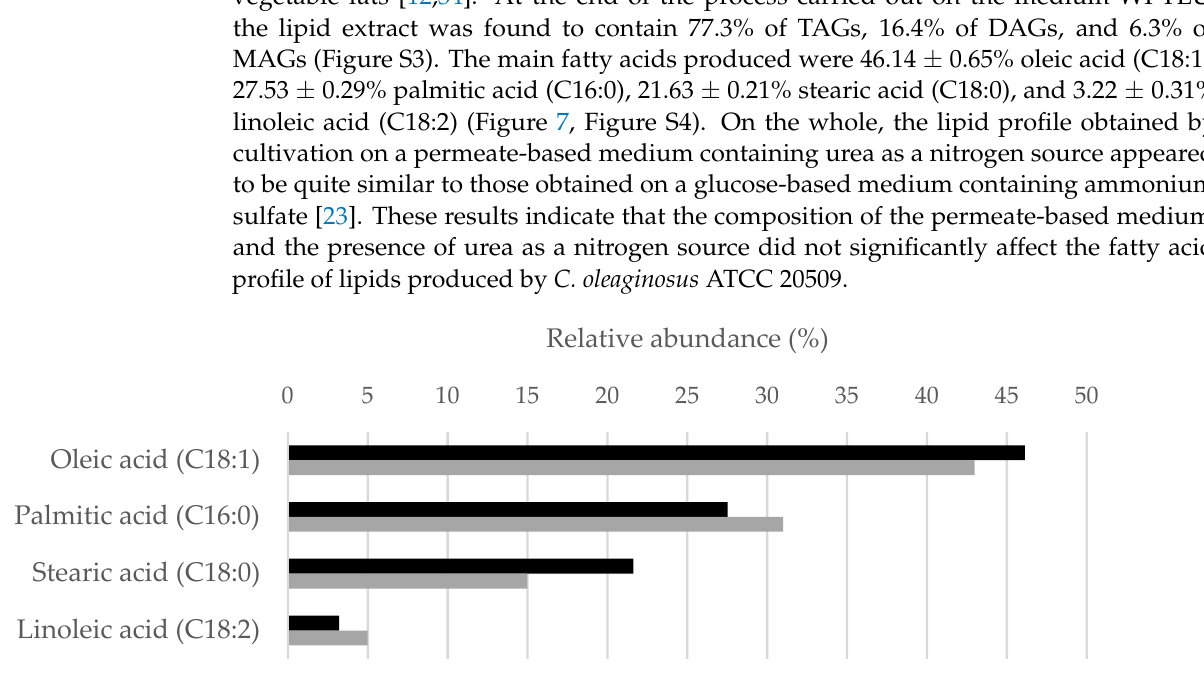
13 of 17 Figure 6. ( a ) FACS histogram showing BODIPY 493/503 fluorescence in ATCC 20509 samples col- lected after 18 h (red line) and 90 h (blue line) of the process in WPYE. Black line = unstained. ( b ) FACS histogram showing BODIPY 493/503 fluorescence in sample collected at 26 h (light blue line), 55 h (blue line), 75 h (pink line), and 90 h (red line) of the process in WPYEU. Black line = unstained. ( c ) Zoomed-in view. In order to obtain a more detailed view on the accumulation dynamic, the process on WPYEU was monitored at several times (after 26, 55, 75, and 95 h). A shift in the fluores- cence intensity signal toward higher values in the samples collected over time was clearly visible, indicating that the progress of lipid accumulation occurred in all the cells (Figure 6b,c). In conclusion, we show that flow cytometry represents a fast and accurate method